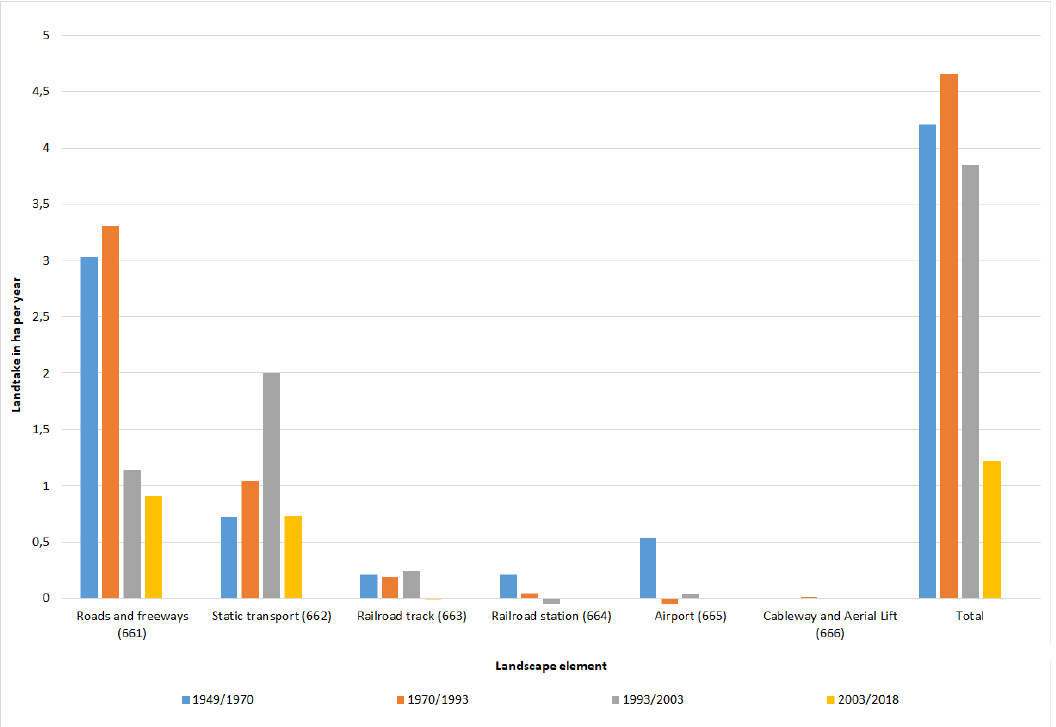
Figure 4. The intensity of landtake by landscape elements related to transportation (hectares per year and period).